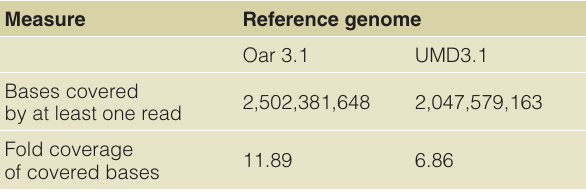
Table 2. Genome coverage for datasets mapped to reference assemblies.